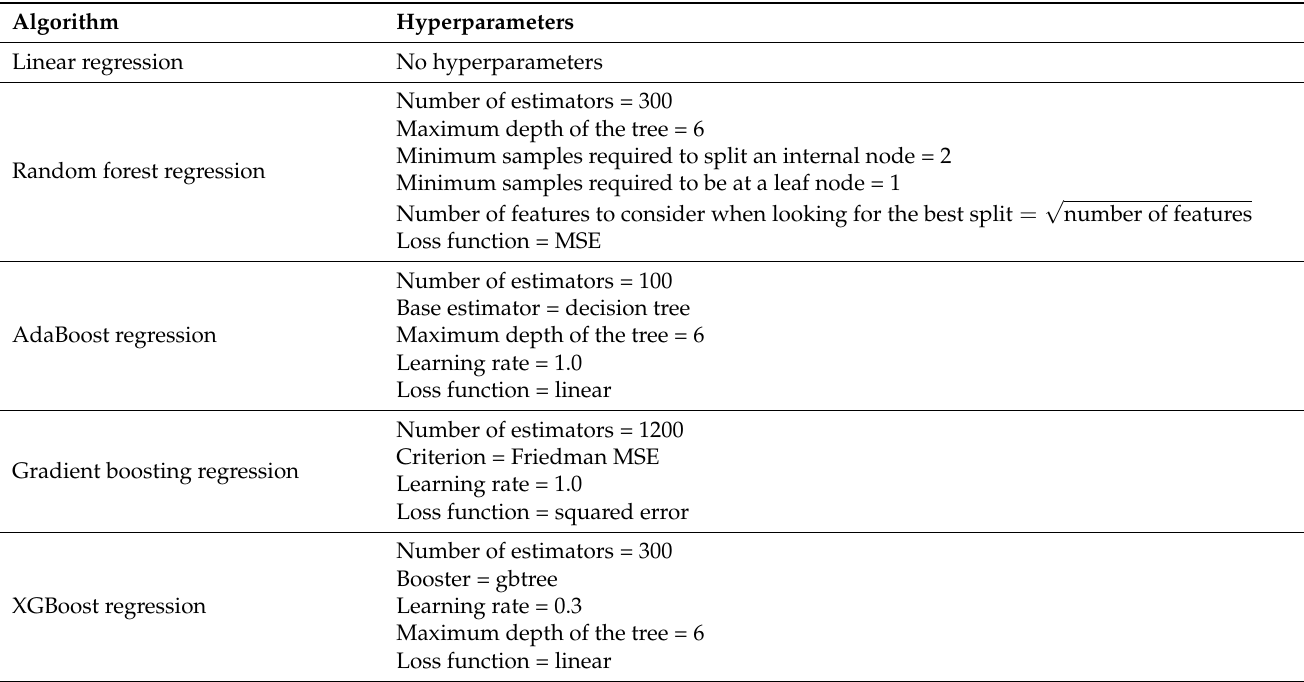
Figure 3. Pearson correlation heatmap for process parameters and tensile strength for case study 1. Table 1. Hyperparameter values used in this